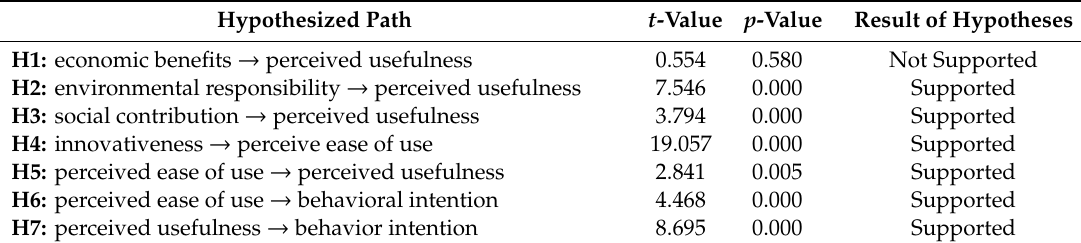
Table 7. Test results of hypotheses